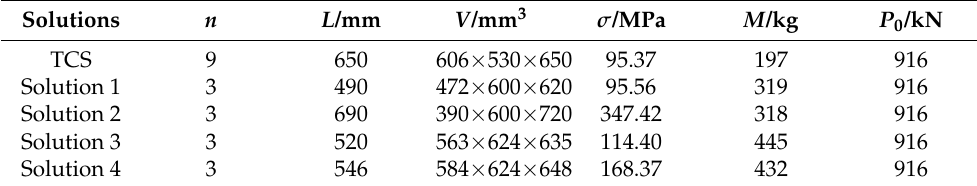
Table 3. Evaluation parameter values of the four TBM ICSs and the TCS.